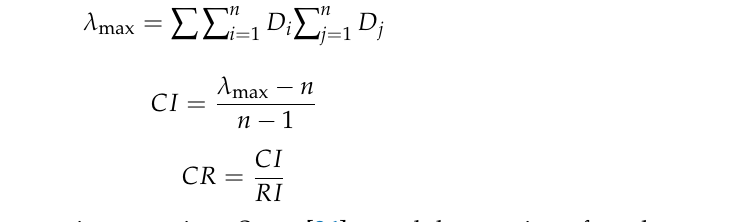
Table 1. The table of random index ( RI )